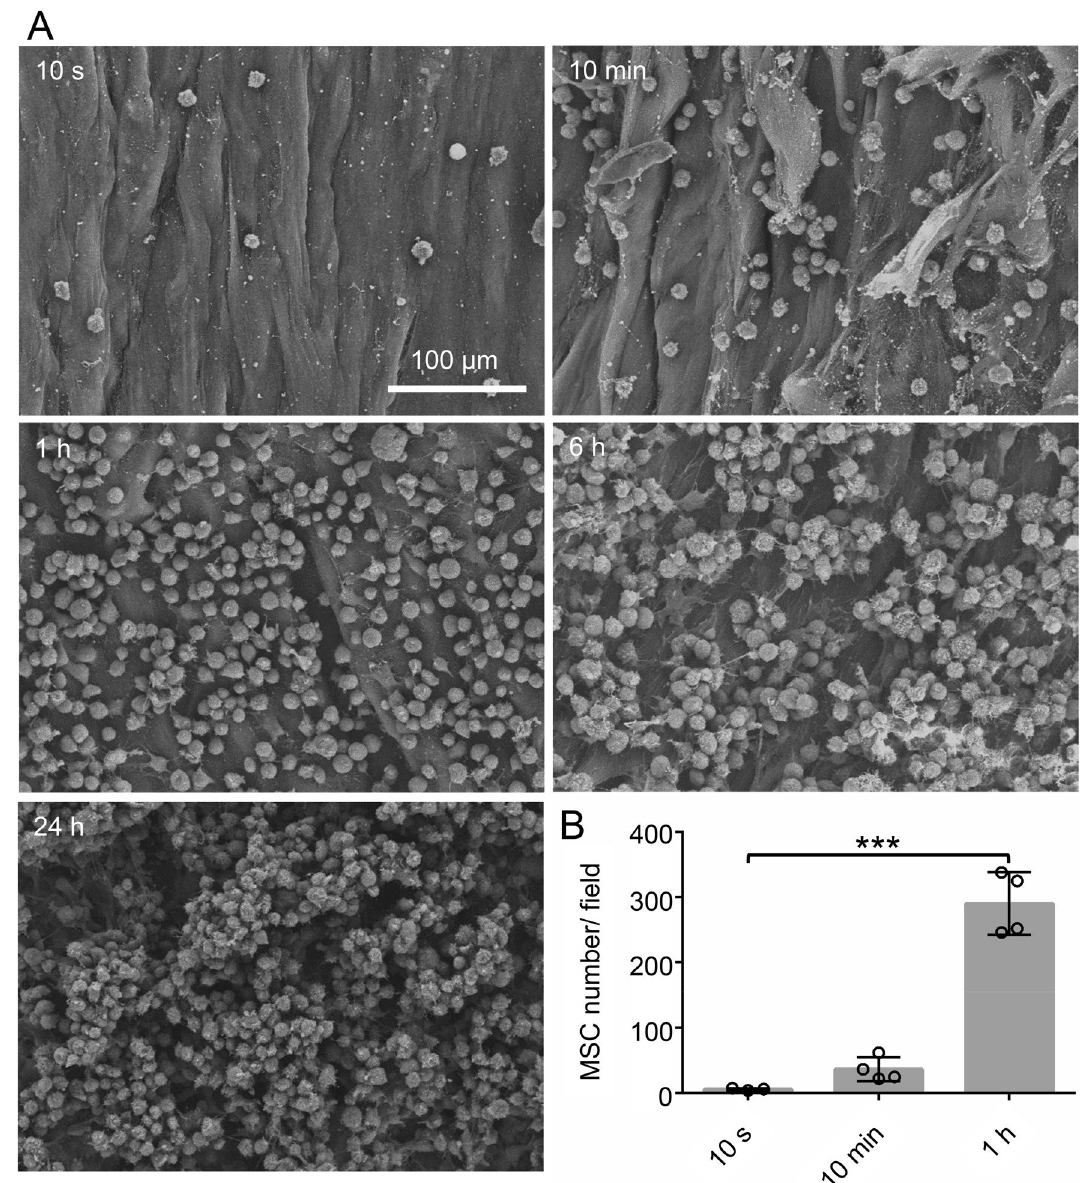
Figure 5. Observation and quantification of adhered MSCs by scanning electron microscopy (SEM). An MSC suspension was placed on the abraded porcine cartilage, and the cartilage was washed after a specified time and observed by SEM. ( A ) SEM images. ( B ) Quantification of adhered MSCs. The number of MSCs in a 320 µm × 380 µm area was counted in 5 or 9 fields per cylindrical cartilage piece. The number of cylindrical cartilage pieces per MSC donor was 2 or 3. This experiment was repeated 3 or 4 times independently and plotted (*** p <